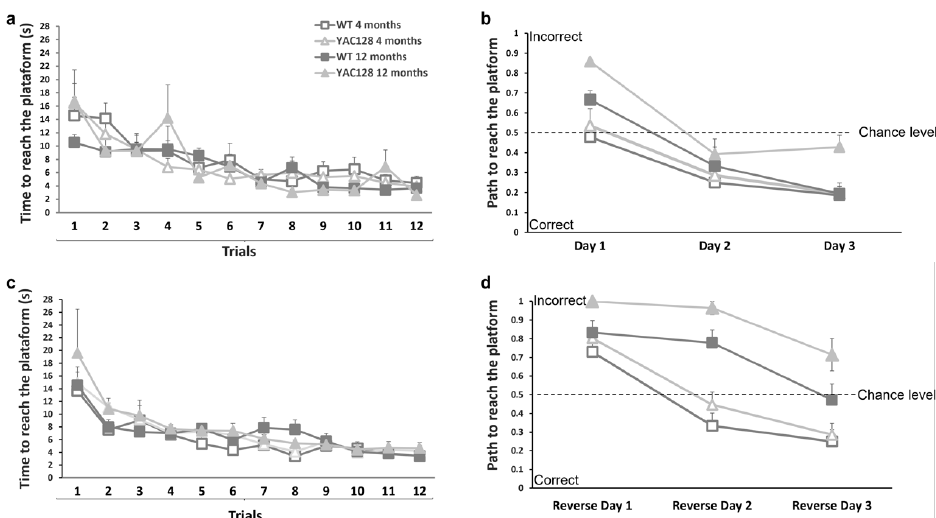
Figure 3. Assessment of spatial learning in early and late symptomatic YAC128 mice and age-matched WT controls. Animals were trained to swim to a platform located in the right arm of a T-maze pool. After 3 days of four trials each day, the platform was switched to the left arm of the maze. The time to reach the platform ( a , c ) and the platform’s path ( b , d ) were recorded. Values represent the means ± SEM. Repeated measures ANOVA and chi-square test with Yates’s correction were used to detect statistical differences, n = 7–9.